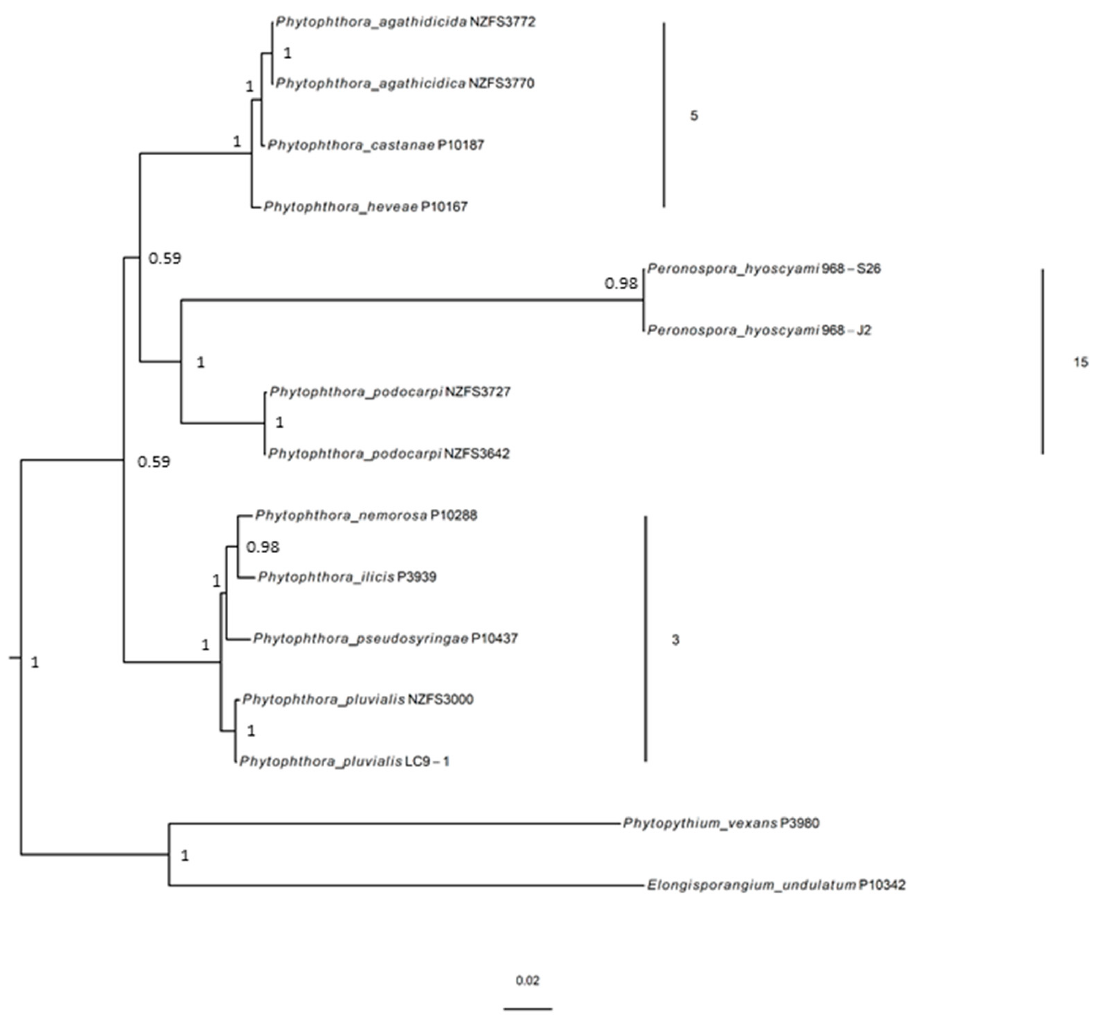
Figure 3. Multilocus phylogeny of Phytophthora showing the placement of the two P. podocarpi isolates in clade 15 along with downy mildew, Peronospora hyoscyami . Complete or partial DNA sequences from seven gene loci (28S rDNA, 60S ribosomal protein, β -tubulin, elongation factor 1- α , enolase, heat shock protein 90, and tigA gene fusion) were used to infer phylogeny with MrBayes in Geneious Pro v9.0. Support is displayed as posterior probability values on the nodes. Scale bar shows number of substitutions per site.